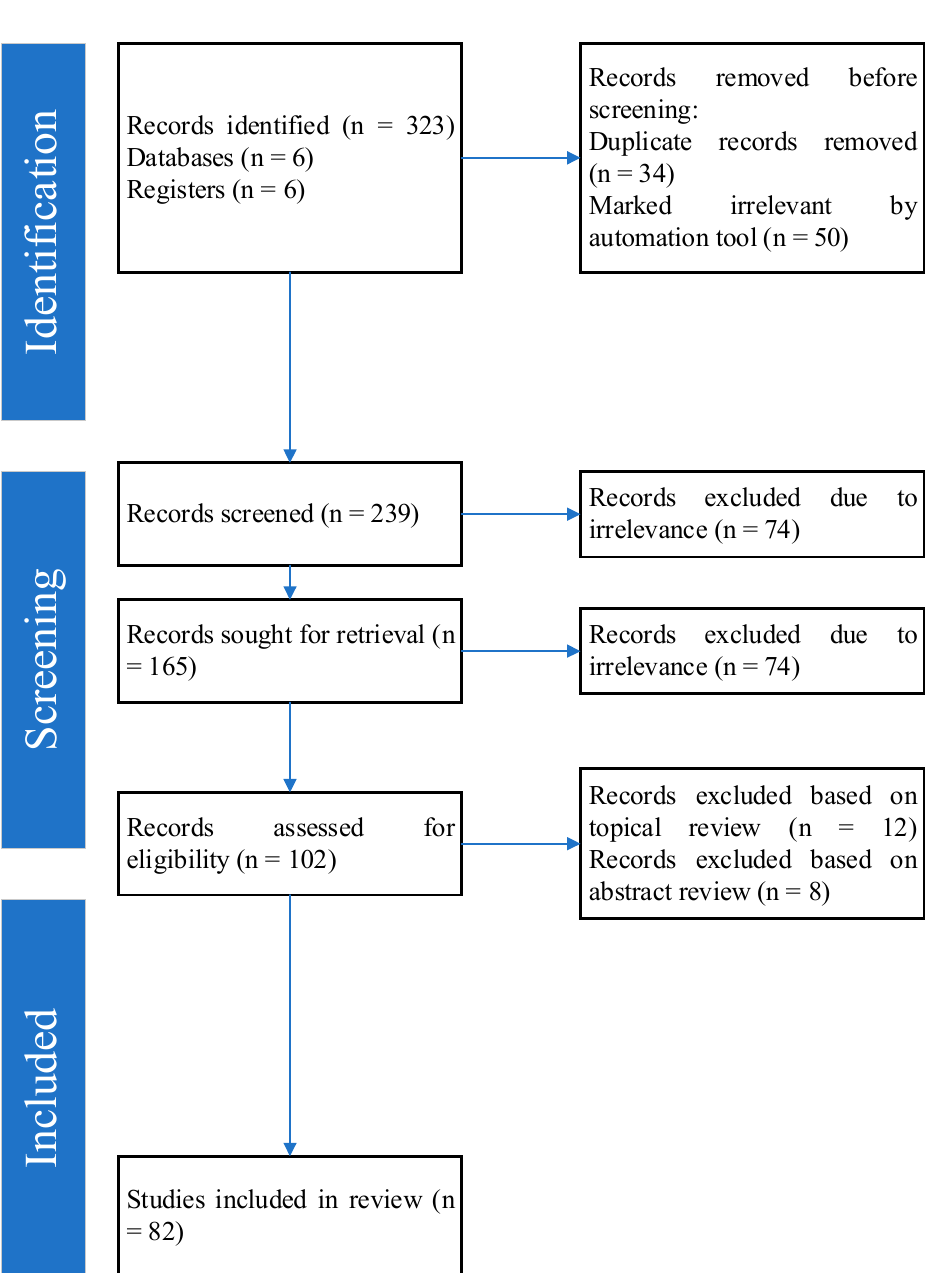
Figure 4. Screening and inclusion and exclusion criteria using the PRISMA framework.